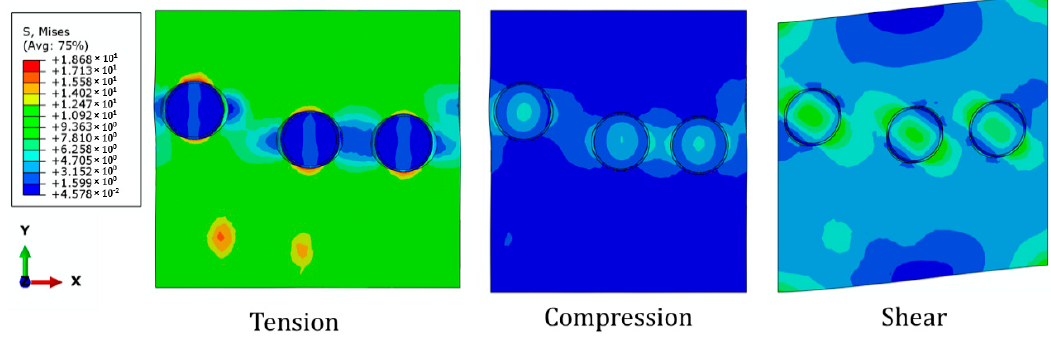
Figure 9. Stress distribution of PLLA/420SS composite with volume fraction of 3% under different loading scenarios (imperfect bonding).